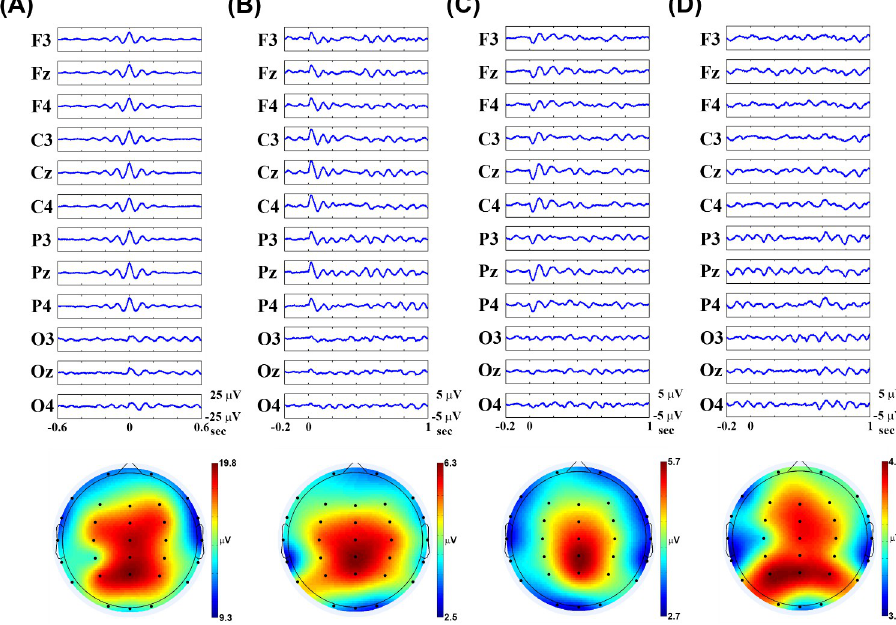
Fig 3. The grand-averaged alpha epochs (top row) with corresponding topographic maps (bottom row) for the four methods. (A) max peak average (MPA), (B) positive average (PA), (C) negative average (NA) and (D) event- related spectral perturbation average (ERSPA)